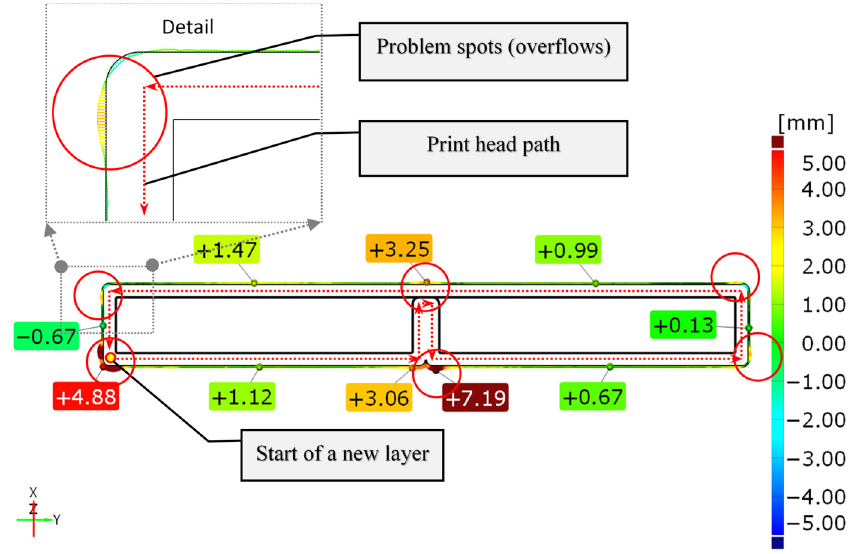
9 of 18 Figure 9. Color map showing deviations between printed and nominal model (28 ‐ day scan). It is clear from the results that the wall element on flat surfaces shows a good agree ‐ ment with the required dimensions (deviations are up to 1 mm), which is quite satisfactory for a concrete element of this size. However, the inspection also shows a significant posi ‐ tive deviation at the point where the nozzle was displaced vertically into the next printed layer (left corner in Figure 9, bottom left corner in the section in Figure 10). By pausing the horizontal movement of the nozzle and not interrupting the concrete mixture extrusion during this time, more mixture than required was extruded at this exposed location, re ‐